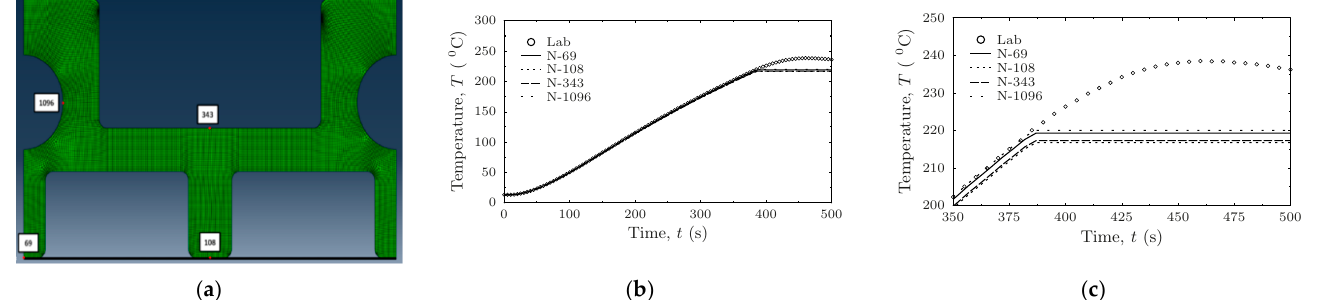
Figure 6. ( a ) Sampling nodes for temperature analysis. ( b ) Temperature profiles of aluminum plate nodes. ( c ) Detailed area to show the delayed temperature profiles.